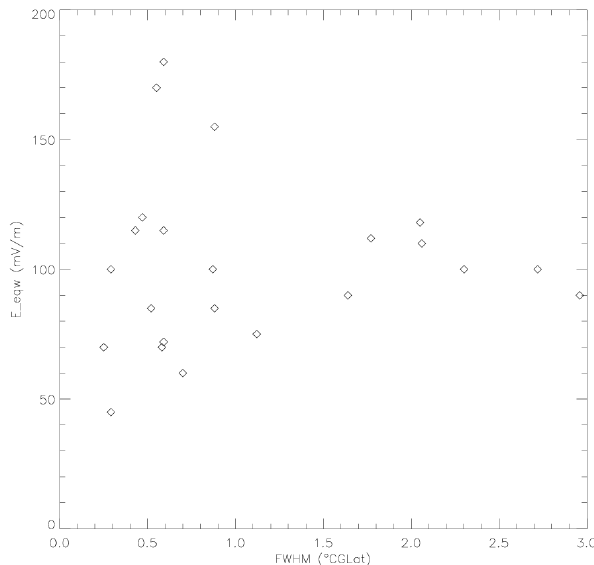
Fig. 5. Peak amplitude of the equatorward electric field component versus the corresponding FWHM for the selected ASAID events.